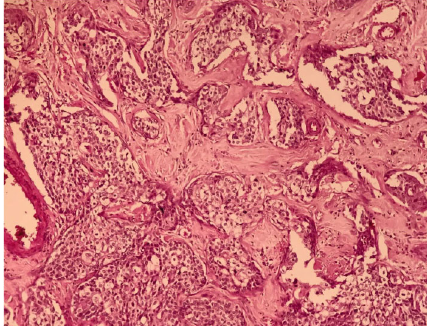
Figure 3: Low magni fi cation HE stain showing tumor proliferation organized in solid islands in fi ltrating the chorion.